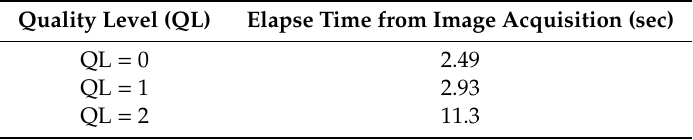
Table 10. Elapse time from image acquisition to each quality